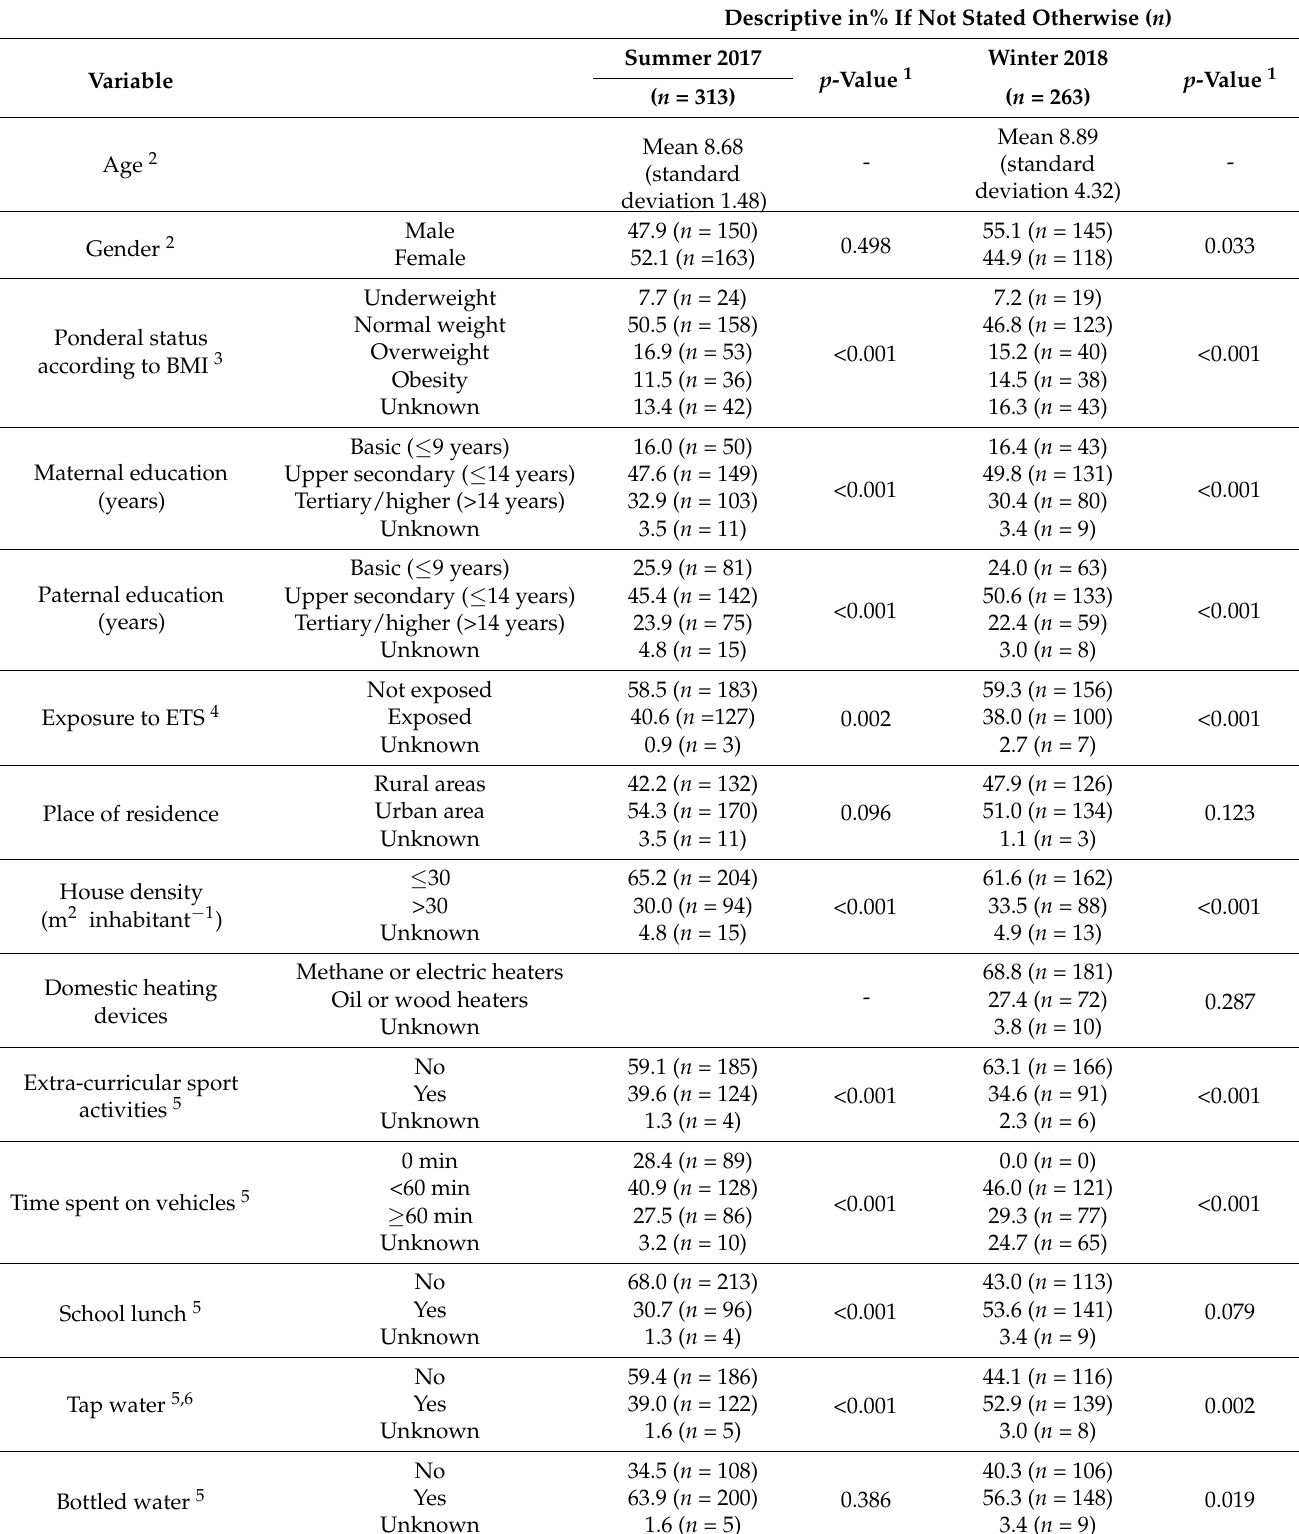
Table 1. Characteristics of the study population participating to the summer and winter biomonitoring campaigns